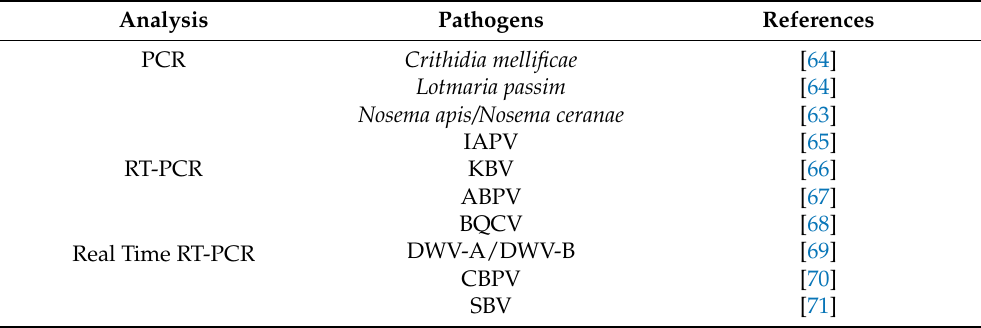
Table 1. Type of analysis, investigated pathogens and references of primers and